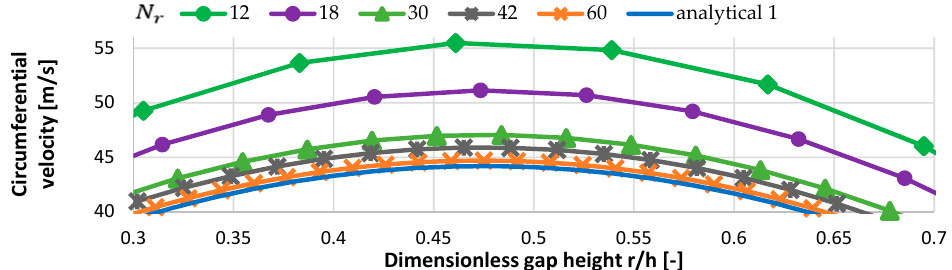
Figure 16. Comparison of the numerical results with di ff erent N r with the analytical solution 1 in the radial gap 2 at N c = 31, 4000 rpm and 50-bar delivery pressure.